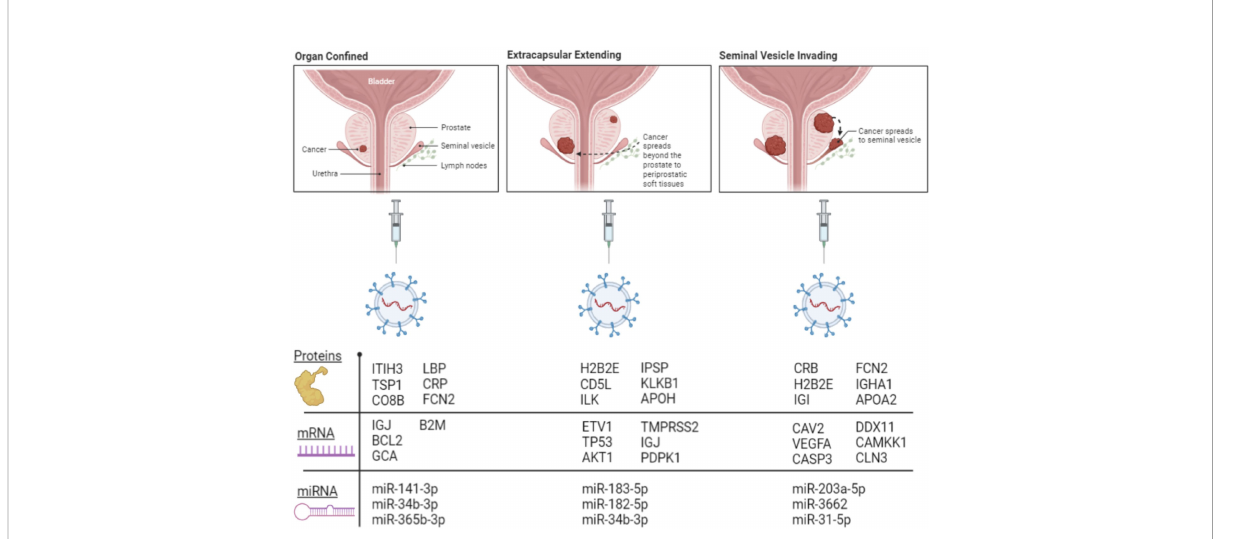
FIGURE 6 Illustration showing selected proteins, mRNAs, and miRNAs with the highest folds of change in each group of PC